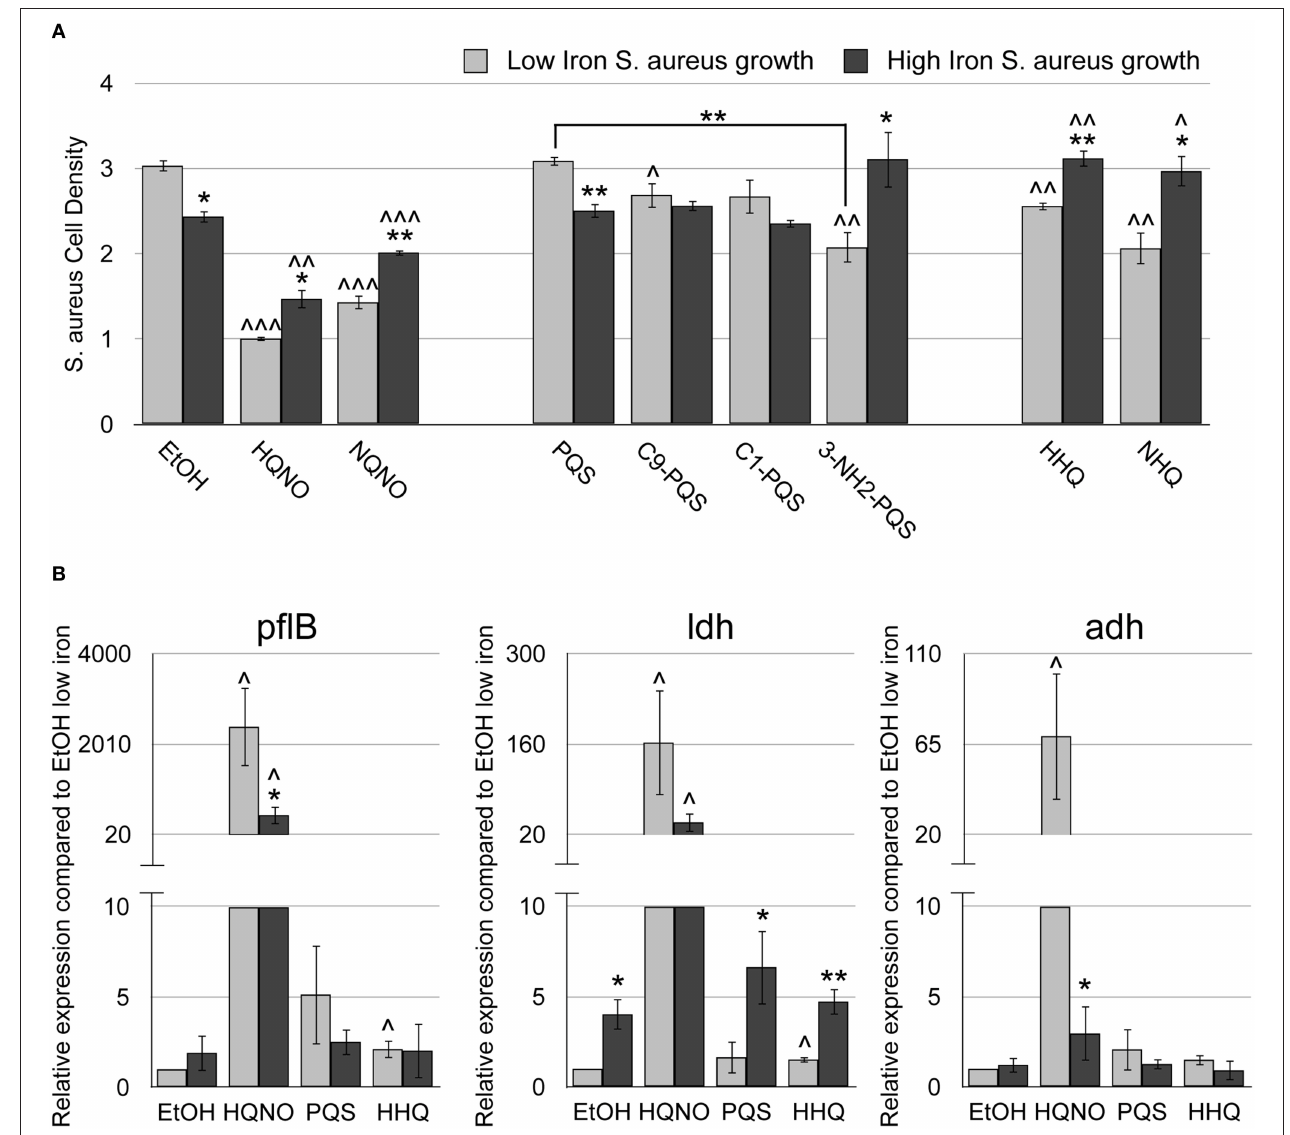
FIGURE 3 | HHQ possesses innate antimicrobial activity. The methicillin-resistant S. aureus (MRSA) M2 strain was grown for 18 h at 37 ◦ C in DTSB, supplemented with or without 100 µ M FeCl 3 and 50 µ M of the indicated AQs. (A) OD 600 of overnight S. aureus cultures was measured. (B) pflB , ldh , and adh mRNA expression was measured by qRT-PCR of MRSA-M2 as described in Section Materials and Methods. Error bars indicate the standard deviation of three biological replicates. Asterisks (*) indicate the following p -values as determined by two-tailed Student’s t -test when comparing low to high iron conditions: * p < 0.05, ** p < 0.005. Carrots ( ∧ ) indicate the following p- values as determined by two-tailed Student’s t -test when comparing AQ treatment to ethanol solvent (EtOH) alone: ∧ p < 0.05, ∧∧ p < 0.005, ∧∧∧ p <